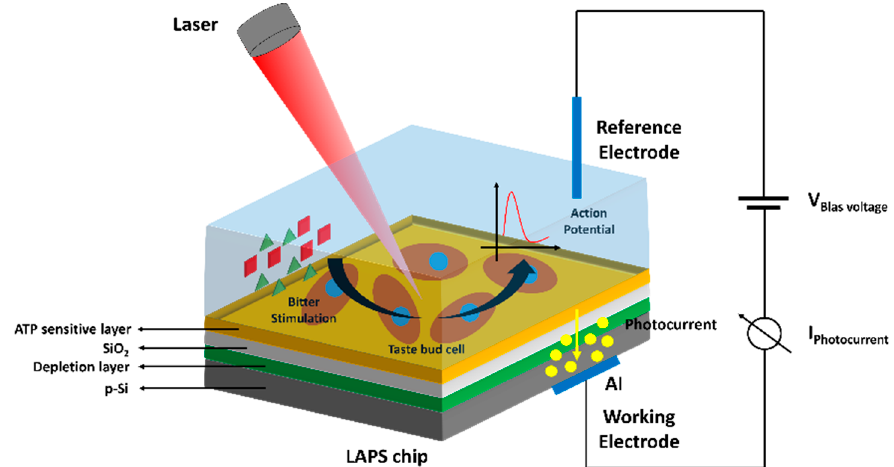
Figure 5. Schematic diagram showing the mechanisms of the LAPS chip for the extracellular recording of cell membrane potential changes of single taste bud cells in response to bitter substances. Adapted from [49]. LAPS: light-addressable potentiometric sensor.